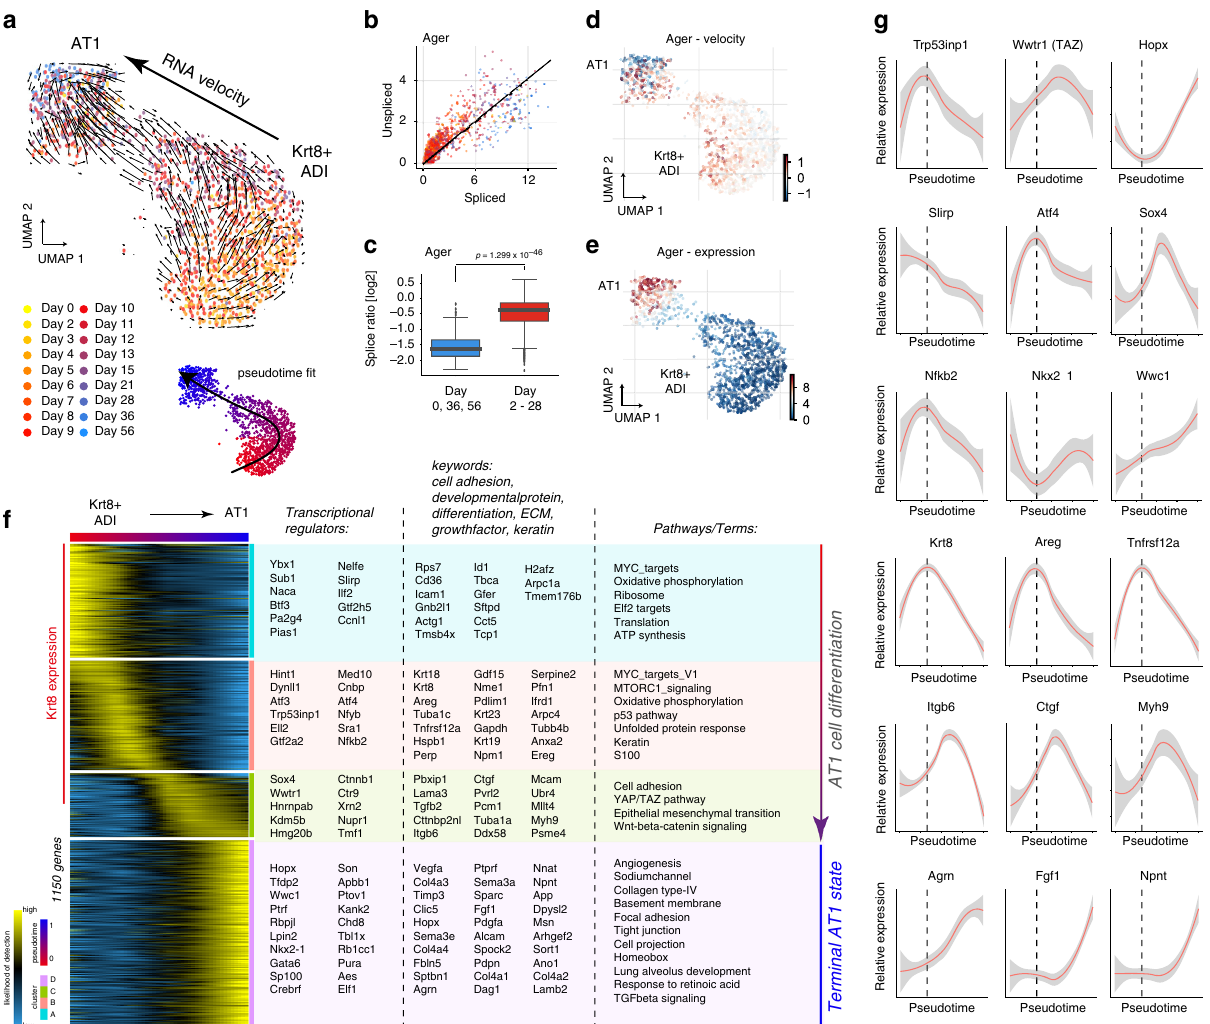
Fig. 8 Terminal differentiation trajectory modeling of Krt8+ADI to AT1. a Velocity plot displays the UMAP embedding colored by time point with velocity information overlaid (arrows), indicating terminal differentiation of Krt8 + ADI into AT1 cells. b The velocity phase plot shows the number of spliced and unspliced reads of the AT1 marker Ager for each cell (points) on the X and Y axes, respectively. Cells are colored by time point and the black line represents the linear steady-state fi t. Cells above and below the diagonal are predicted to be in inductive or repressive states, respectively. c The Boxplot shows the log2 ratio of unspliced over spliced Ager reads for days 0, 36 and 56 (blue, n = 100 cells) and all other time points (red, n = 1193 cells). To avoid division by zero, one was added to both counts. Statistical signi fi cance was assessed by using Wilcoxon rank-sum test (two-sided). The boxes represent the interquartile range, the horizontal line in the box is the median, and the whiskers represent 1.5 times the interquartile range. UMAP embedding colored by Ager velocity ( d ) and expression ( e ) displays a gradual increase along the inferred trajectory. f The heatmap shows the gene expression patterns across the differentiation trajectory for 1150 altered genes. g The line plots illustrate smoothed expression across the differentiation trajectory for a number of exemplary genes. Gray colors represent the con fi dence interval derived from the smoothing fi t. The dotted line indicates the peak of Krt8